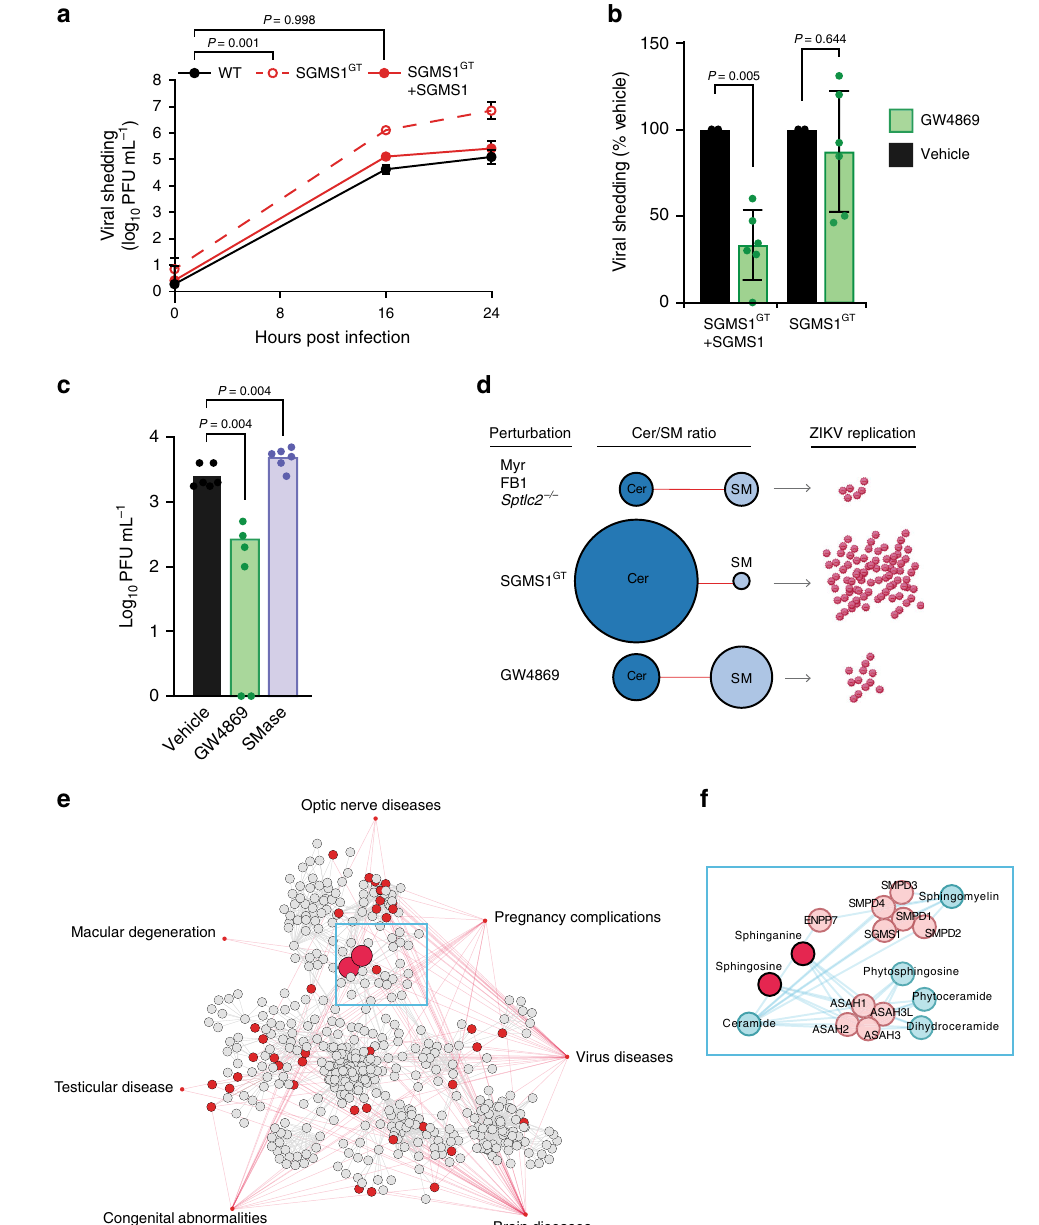
Fig. 6 Elevated ceramide levels increase ZIKV infection. a KBM7 WT, SGMS1 GT , and SGMS1 GT + SGMS1 cells were infected with ZIKV (MOI = 1). At the indicated timepoints, culture supernatants were collected and titrated by plaque assay; n = 8 biological replicates. Two-way ANOVA with Dunnett ’ s multiple-comparison test. b KBM7 SGMS1 GT and SGMS1 GT + SGMS1 cells were infected with ZIKV (MOI = 1) and treated with 10 μ M GW4869 or vehicle. At 24 hpi, supernatants were collected and analyzed by plaque assay; n = 6 independent infections. Two-tailed Student ’ s t test. c Huh7 cells were infected